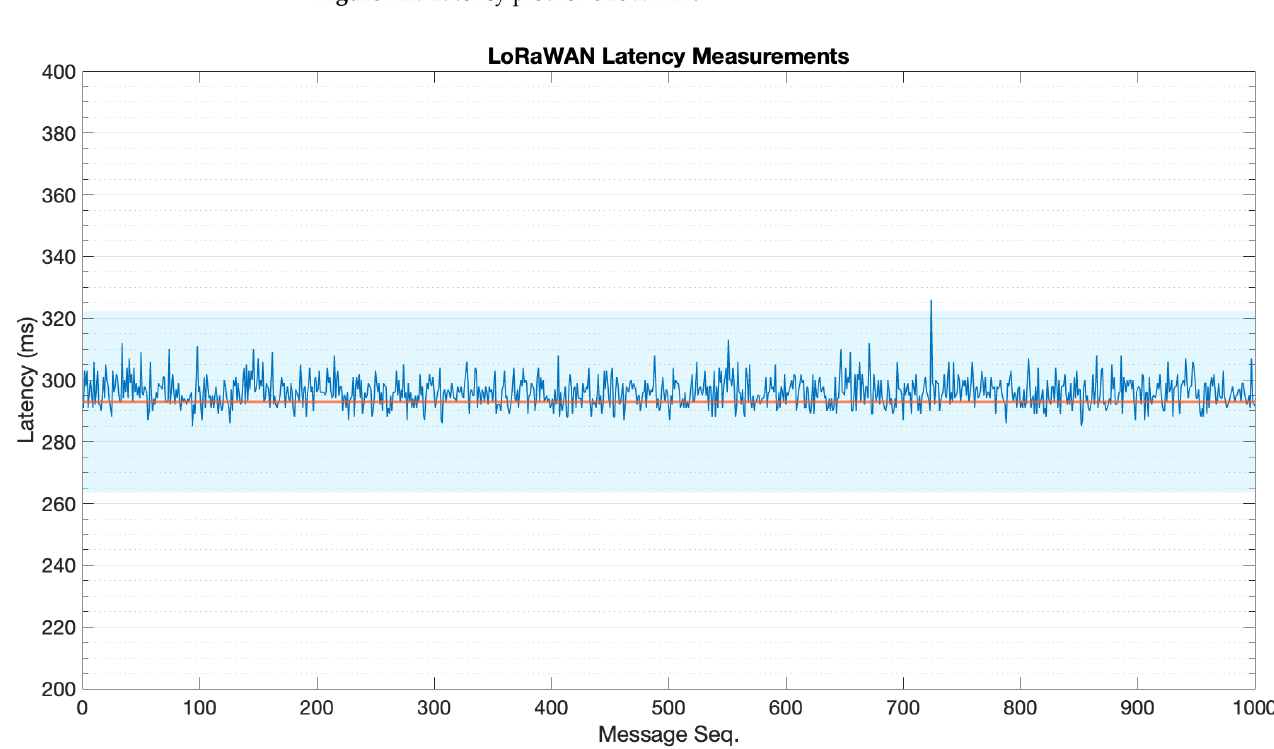
Figure A3. Latency plot for LoRaWAN.